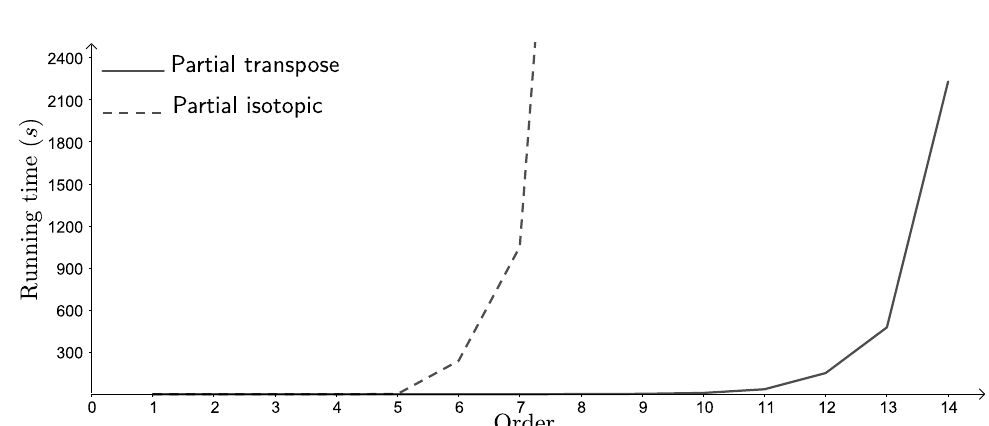
Figure 9. Running time (in seconds) required for computing the cardinality of the set V Q ( I PT ( L )) , for random Latin squares L ∈ L n , with 1 ≤ n ≤ 14.